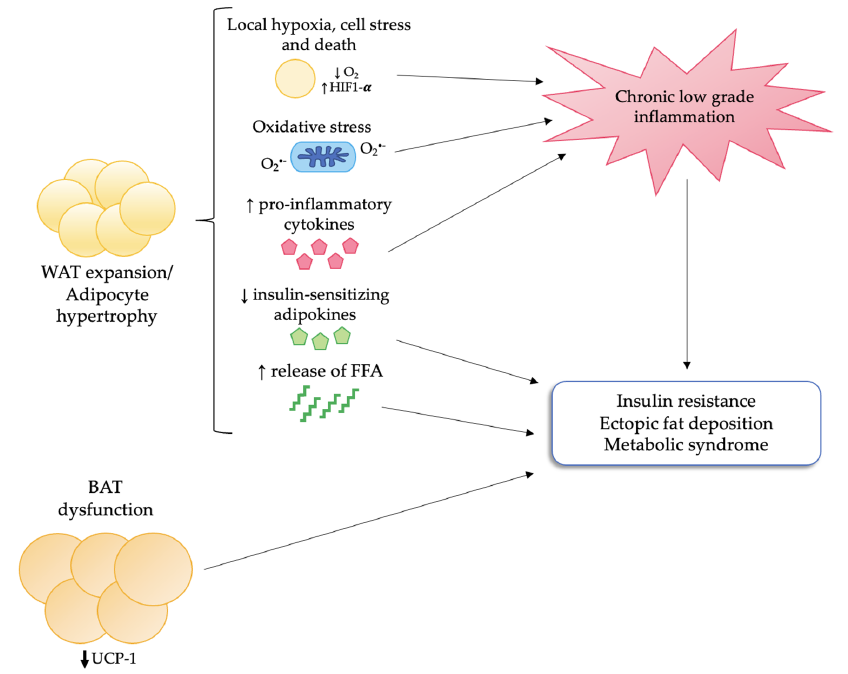
Figure 1. Adipose tissue dysfunction in obesity. In obesity, WAT responds to calorie overload mainly through adipocyte hypertrophy. This leads to local hypoxia, cell stress and death, oxidative stress, and increased secretion of pro-inflammatory cytokines with subsequent infiltration of mac- rophages and development of chronic low-grade inflammation. Moreover, hypertrophic adipocytes display an impaired secretion of insulin-sensitizing molecules, such as adiponectin, and an in- creased release of FFA. All these changes, together with BAT dysfunction and impaired browning of WAT, eventually lead to insulin resistance, ectopic fat deposition, and metabolic syndrome. Ab- breviations: BAT, brown adipose tissue; FFA: free fatty acids; HIF-1 α : hypoxia inducible factor-1 α ;